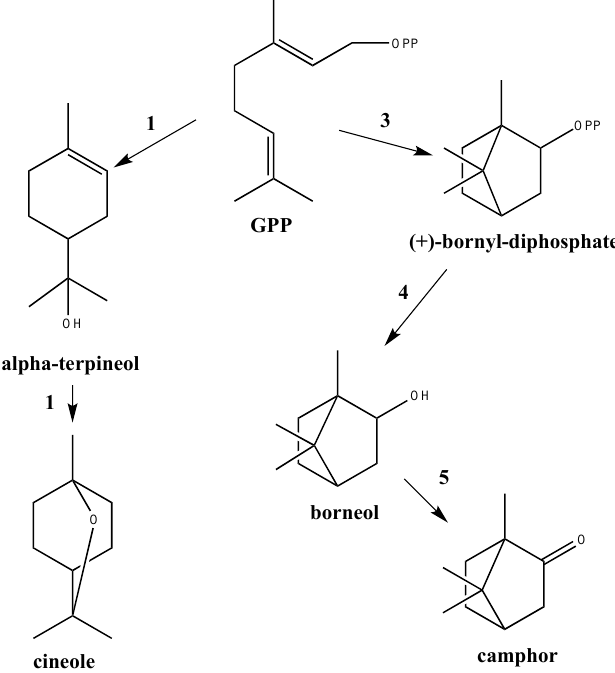
Figure 2. Scheme for the synthesis of the monoterpenes cineole and camphor. GPP, geranyl diphosphate; 1, cineole synthase; 2, bornyl diphosphate synthase; 3, bornyl diphosphate diphosphatase; 4, borneol dehydrogenase. Adapted from [22–25].